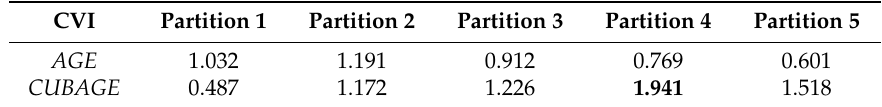
Table 4. The AGE (averaged information gain of isolating each cluster) and CUBAGE (clustering utility based on AGE ) outcomes of the partitions in Table 2.